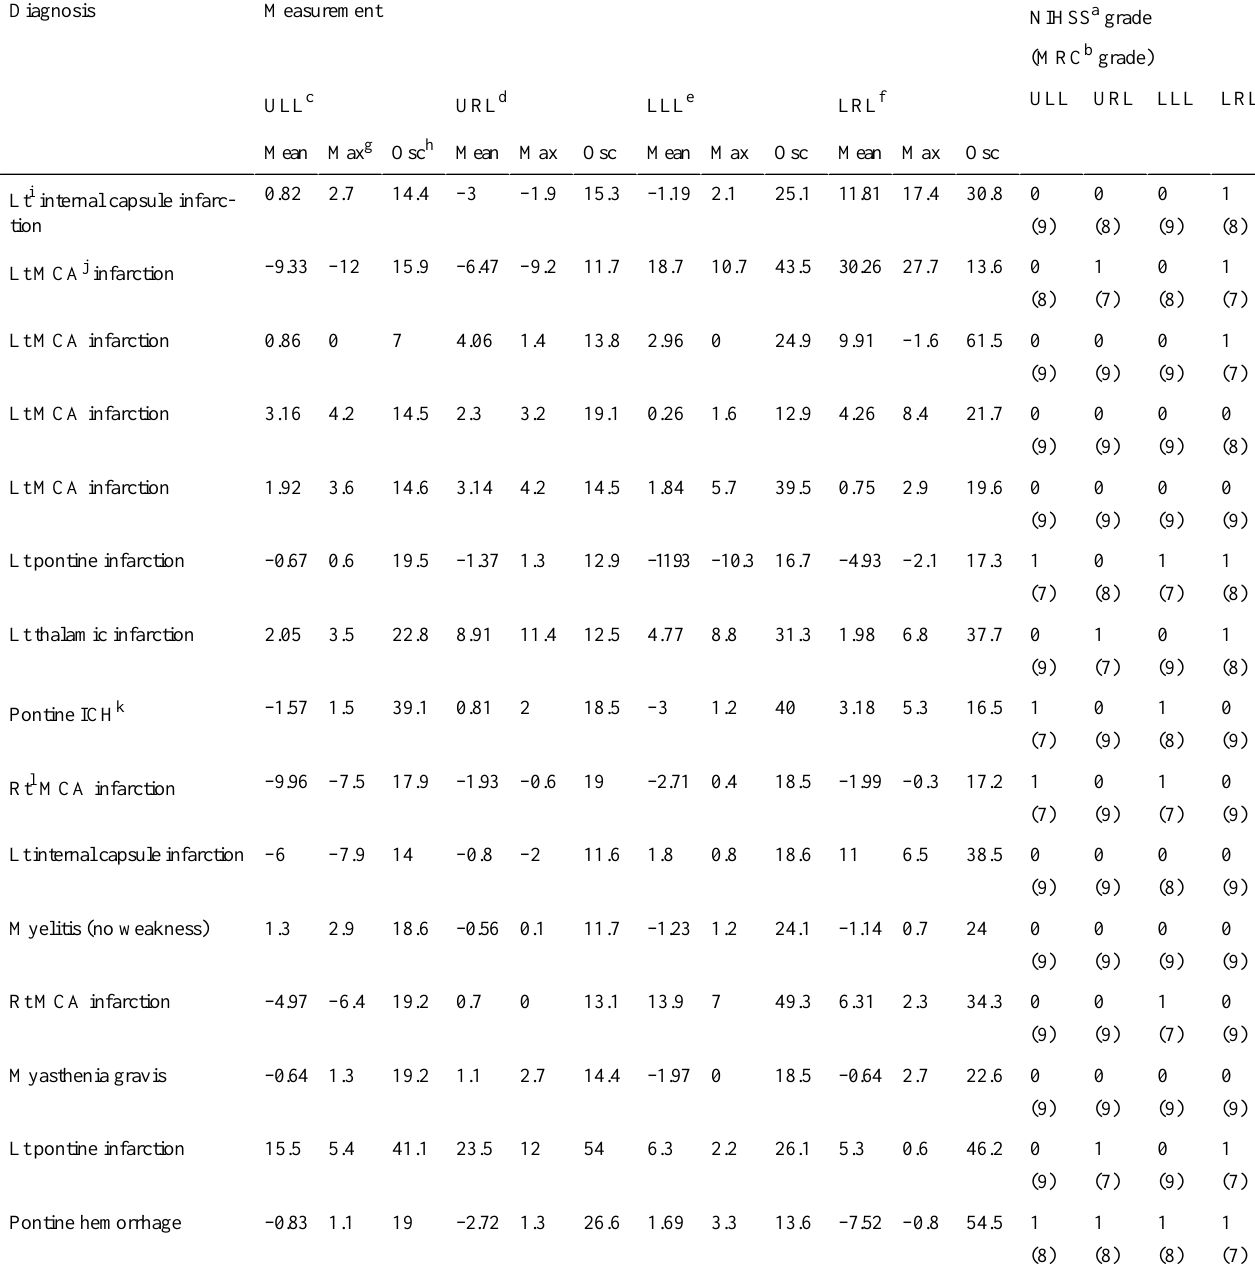
Table 2. Summary of patients and test data.